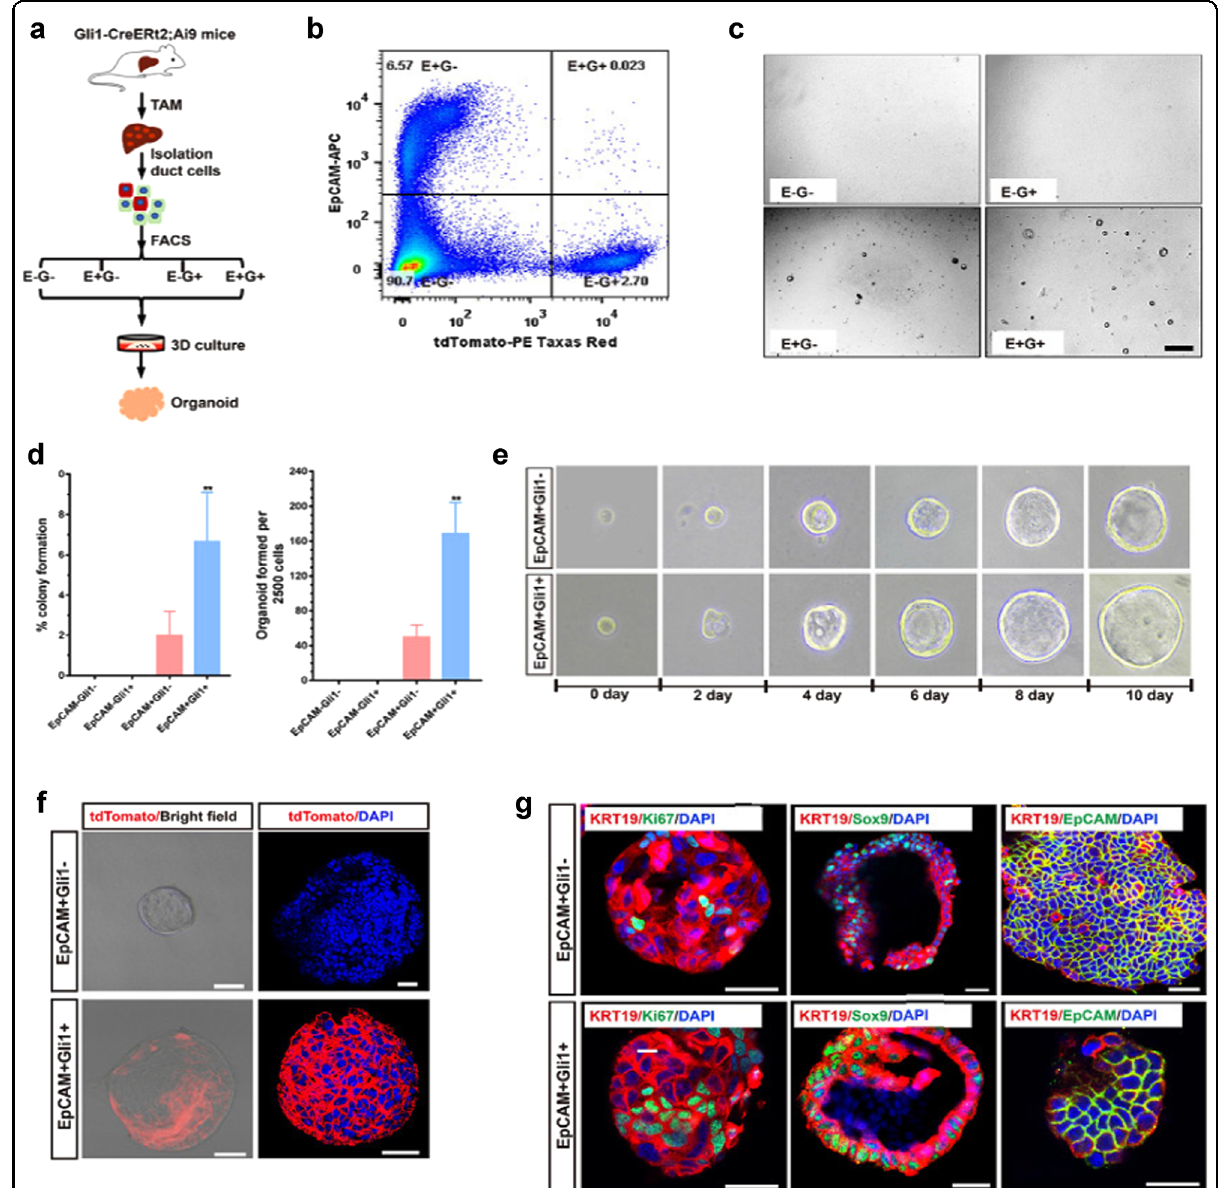
numbers of organoids formed per 2500 single cells (right). Data are presented as means ± SEM ( n = 3). ** P < 0.01. e Representative images of